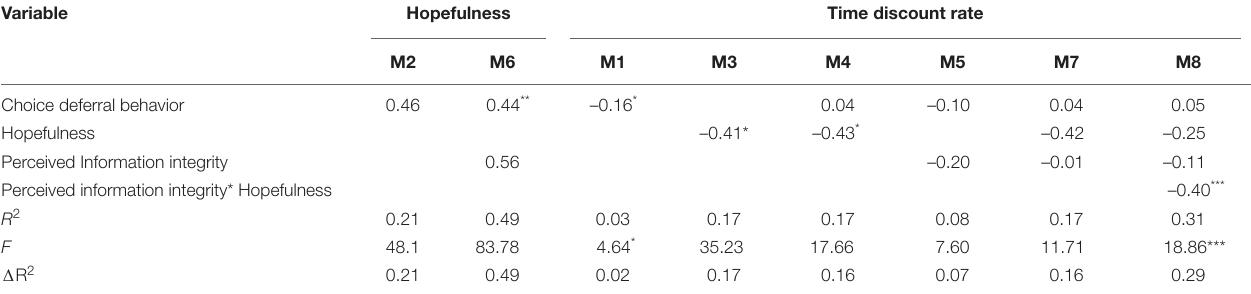
TABLE 3 | Analysis of the results of hierarchical regression.